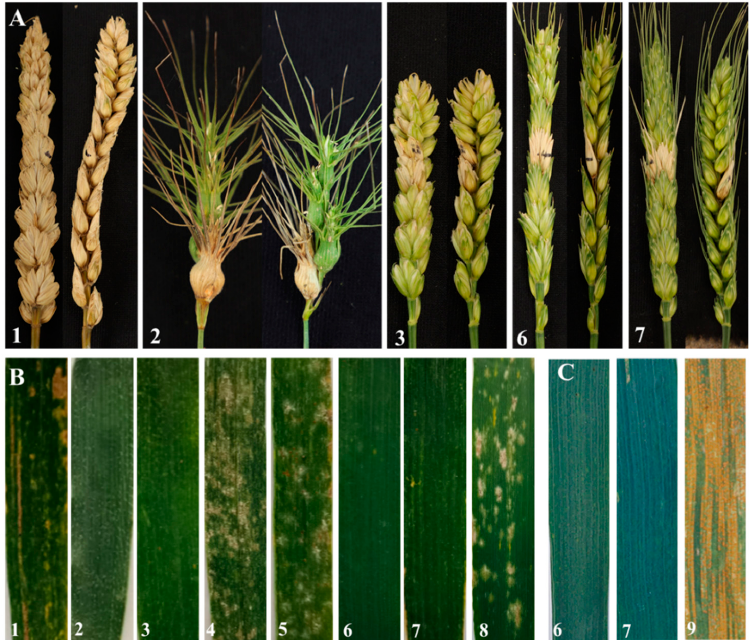
Figure 5. Disease reaction of two lines and their parents. ( A ) Spikes infected with Fusarium graminearum . ( B ) Leaves infected with Blumeria graminis at the adult stage. ( C ) Leaves infected with Puccinia striiformis at the adult stage. 1, Triticum aestivum cv. Chinese Spring; 2, Ae. geniculata ; 3, wheat- Ae. geniculata 7M g addition line W166; 4, Abbondanza nullisomic line 7A; 5, Abbondanza nullisomic line 7B; 6, W623; 7, W637; 8, Shaanyou 225; 9, Huixianhong.